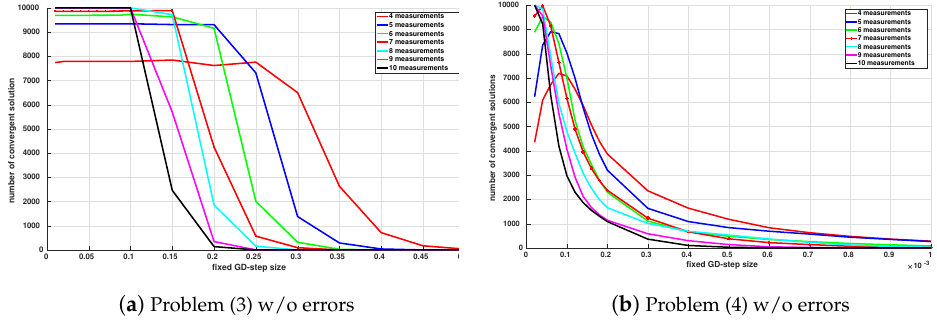
Figure 2. Convergence results on 10,000 simulations using GD with fixed-step descent for estimation problems (3) ( a ) and (4) ( b ), respectively, without explicitly considering positioning and measurement error models and by varying the number of neighboring nodes from 4 to